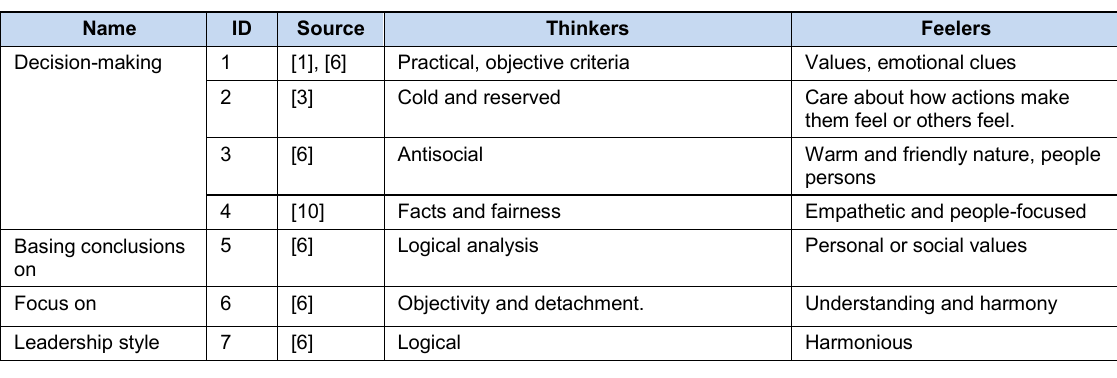
Table 3. Dimension Thinkers/Feelers